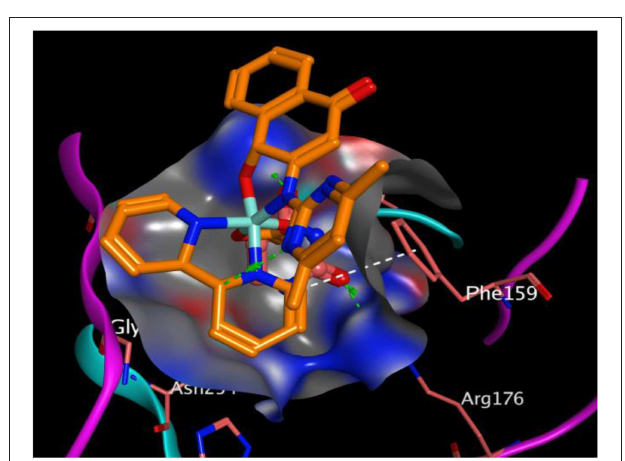
FIGURE 5 | Binding pose of compound 2 in the binding cavity of 1WS3 (the green dotted lines signify H-bond; white dotted lines signify H-pi interaction).